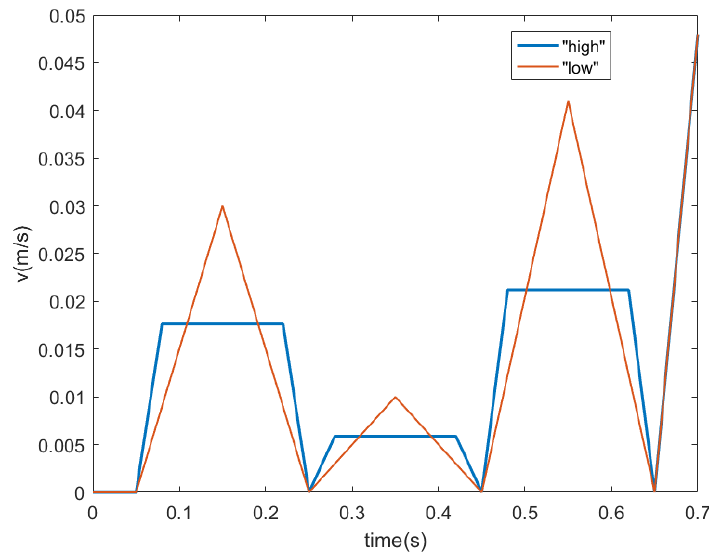
Figure 7. The definition of “high” and “ low ” for the mobile